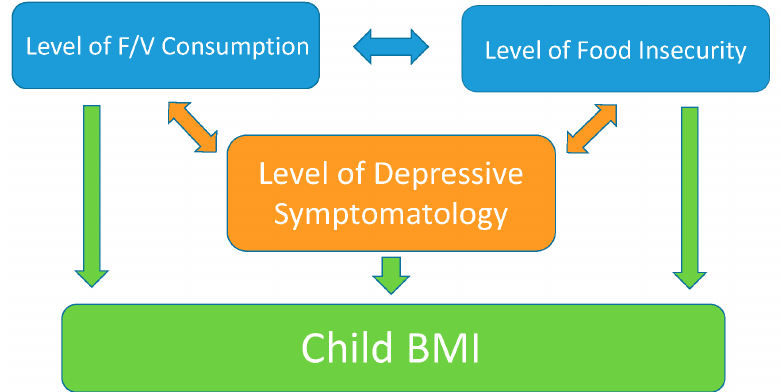
Figure 1. Conceptual Model Depicting the Relationship Between Maternal Depression and Obesity